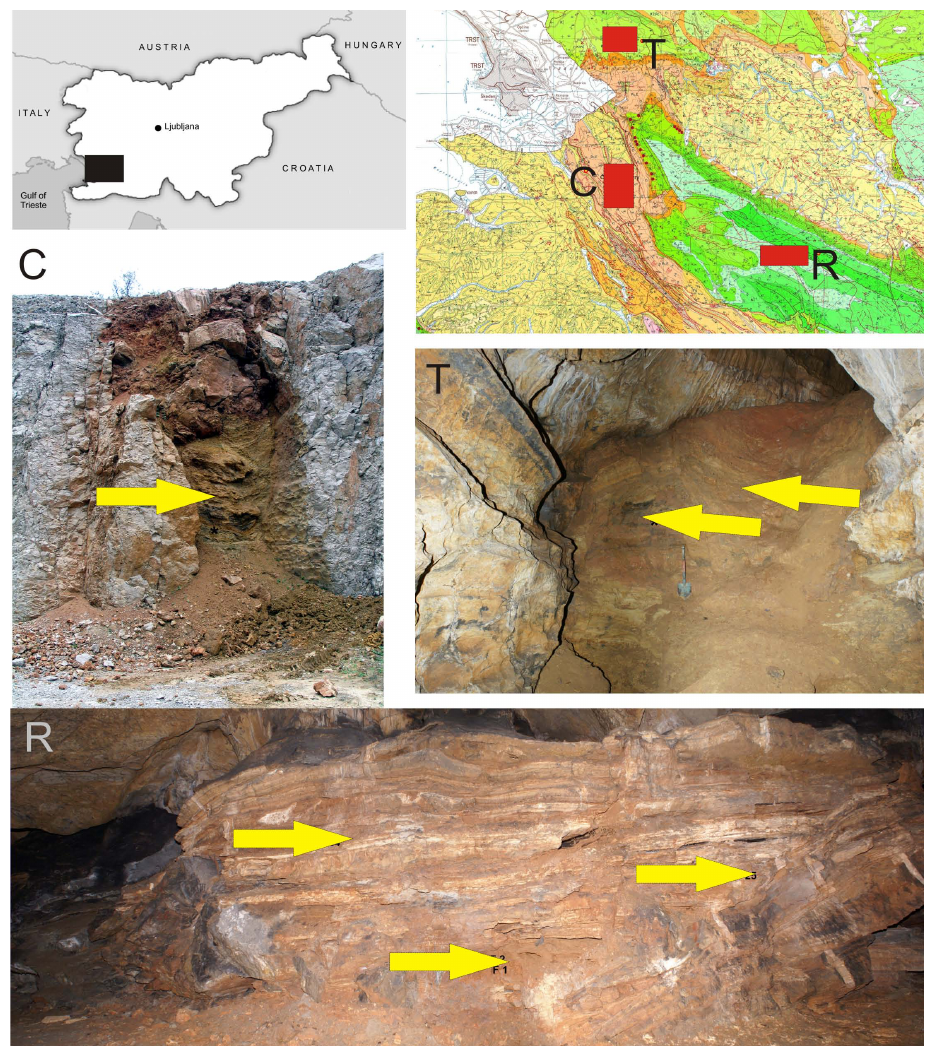
Fig. 1. Location of the studied sites in Slovenia (see the geological map in the upper right corner; map after Pleniˇcar et al., 1969): C=fossil cave in the ˇCrnotiˇce Quarry (the section is represented by an unroofed cave filled with yellow fluvial sediment covered by red clay with flowstone), T=Trhlovca Cave (the oldest part of the section with fluvial sediments), R=Raˇciˇska peˇcina Cave (the section is an alternation of flowstone and clay deposits; Photos by A.